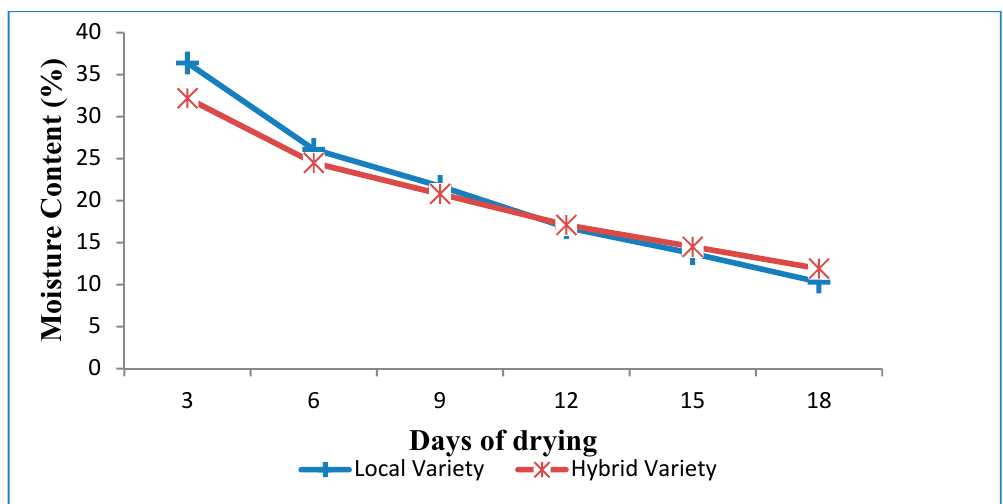
Figure 7. Moisture content of the coconut wastes by days of sun drying.